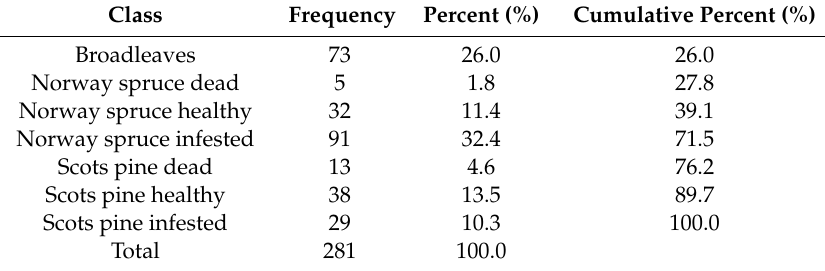
Table 1. Classification summary table including both tree species and health status assessment from the reference